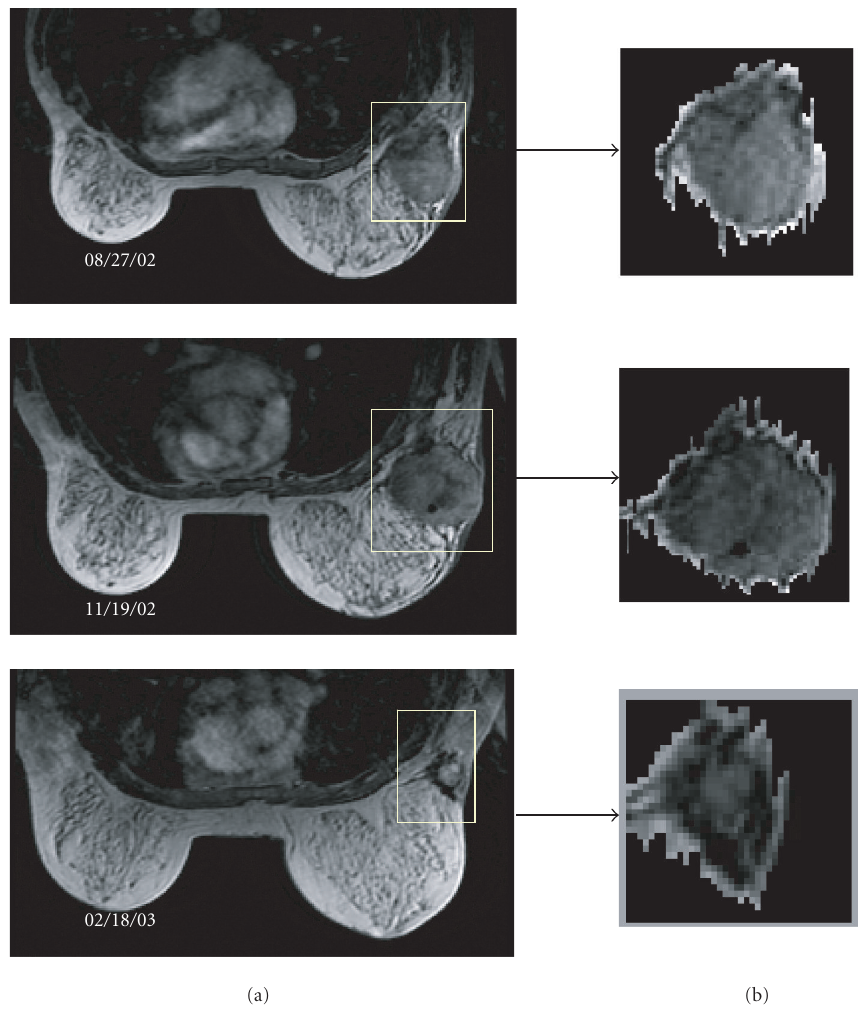
Figure 7: DCE-MRI as a potential endpoint in monitoring tumor’s response to anti-angiogenic therapy. Three sets of DCE-MRI data of the same tumor were acquired and are shown in (a). The tumor sites were extracted via advanced image segmentation tools and are highlighted in (b). The pattern changes are consistent with the clinical foundings that, even as a responsive case, most tumors’ volume will grow initially but shrink lately with much reduced vascular